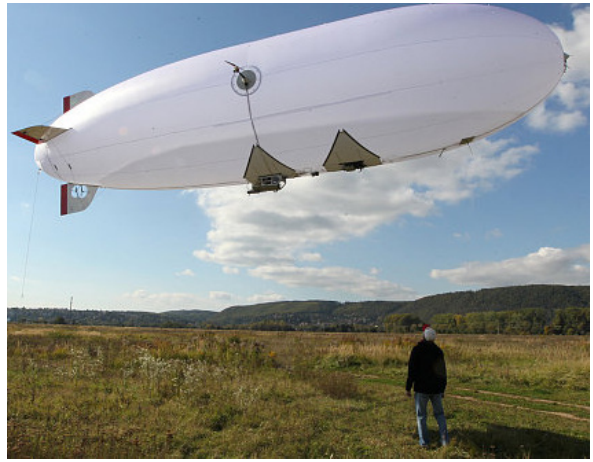
Figure 1. UAV airship